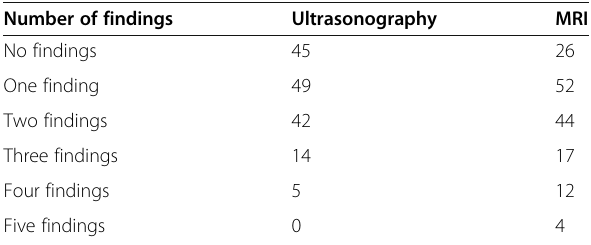
Table 2 Number of findings in each knee as detected by ultrasonography and MRI